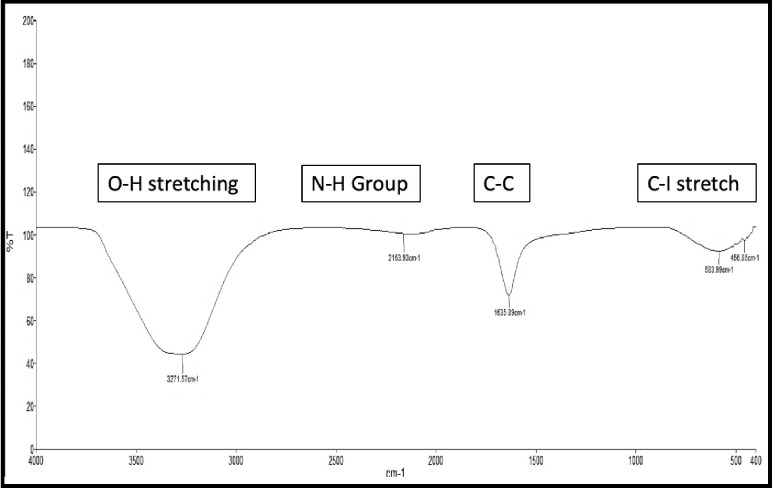
FTIR spectrum of the TiO2 NPs.